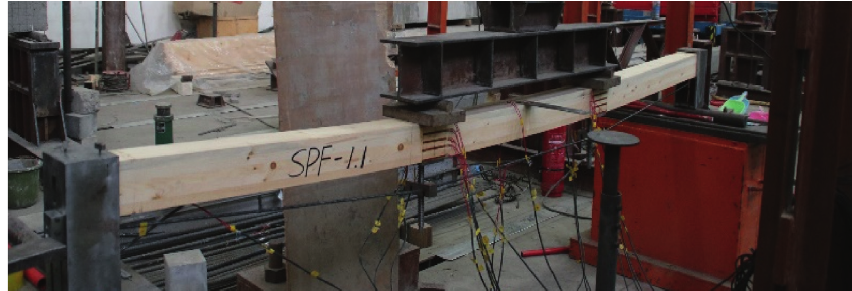
Figure 1: Prestressed glulam